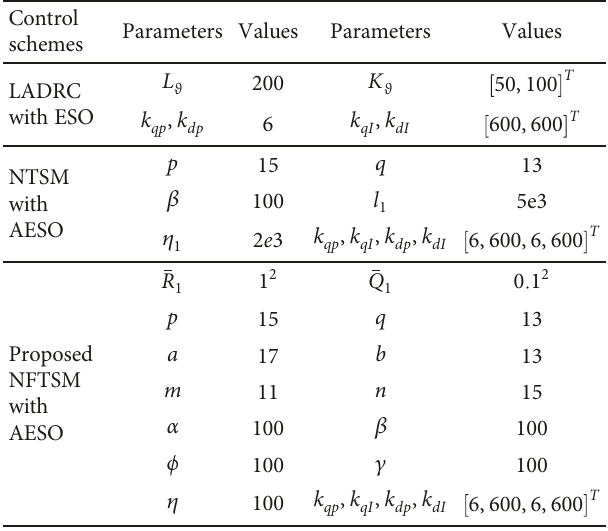
Figure 7: Forces on hose and probe during coupling without vibration suppression. Table 3: Parameters of the di ff erent control